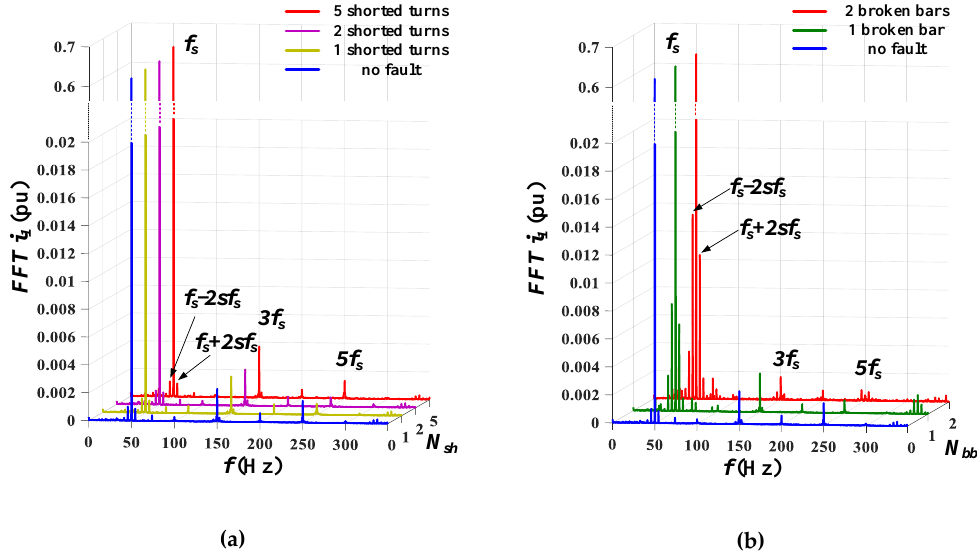
Figure 5. FFT analysis of the positive-sequence instantaneous symmetrical component i 1 of the stator current for nominal load torque and f s = 50 Hz with ( a ) different number of shorted turns N sh ; ( b ) different number of broken bars N bb .